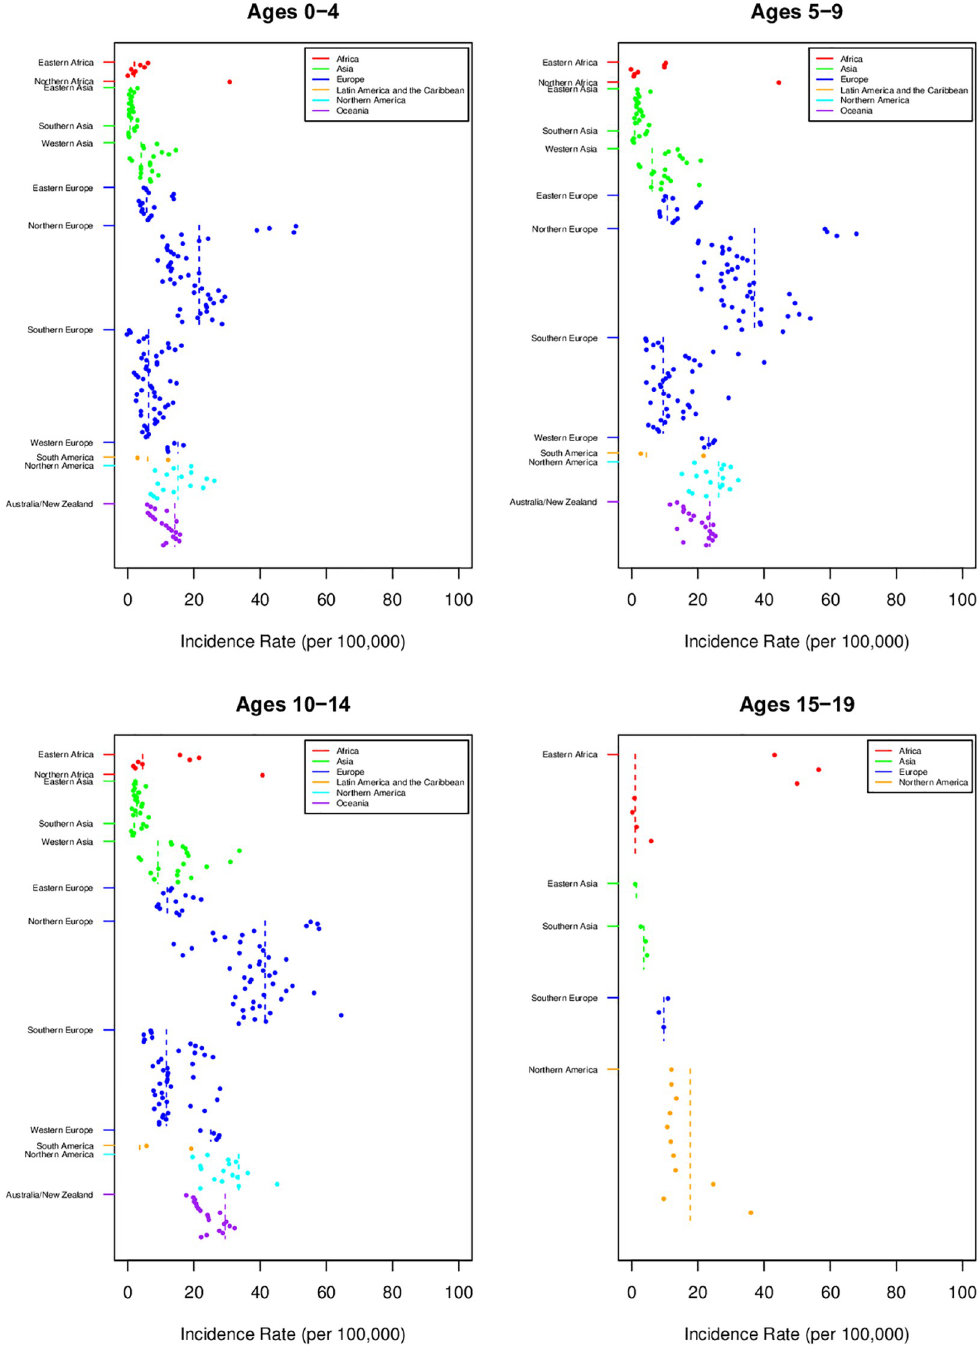
Fig 3. Variation in TlD incidence rates for age groups 0–4, 5–9, 10–14, 15–19 years by region. [Point sizes are proportional to their weight (i.e. inverse variance). The lines indicate means and shaded areas indicate 95% Cls].